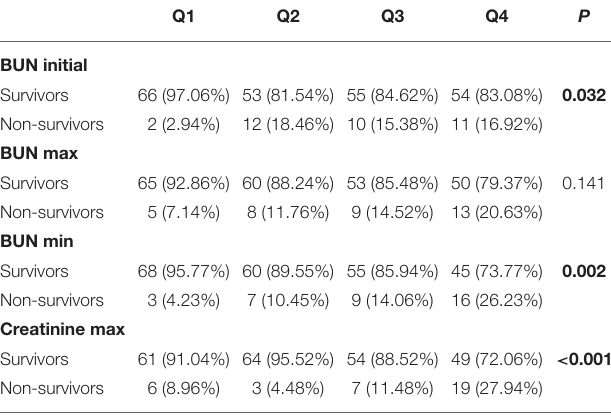
TABLE 3 | The relationship between BUN and creatinine with hospital mortality. Q1 Q2